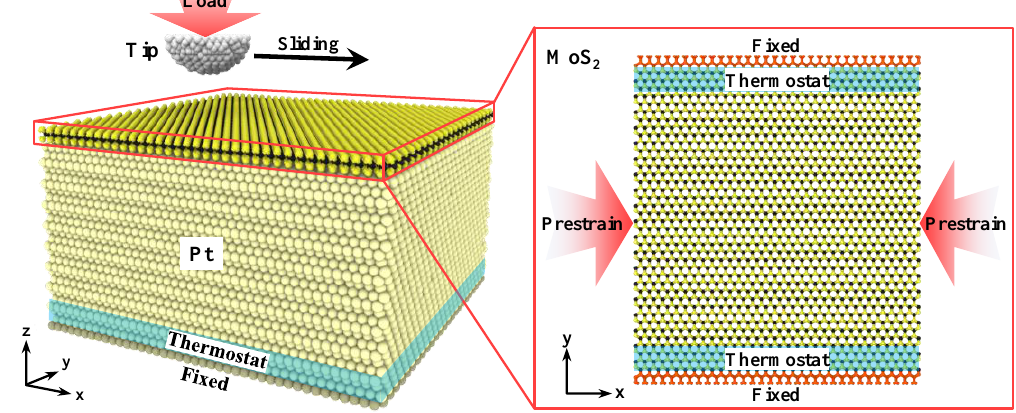
Figure 1. MD simulation model of a diamond tip and MoS 2 / Pt substrate. Table 1. Prestrain parameters of MoS 2 along the x